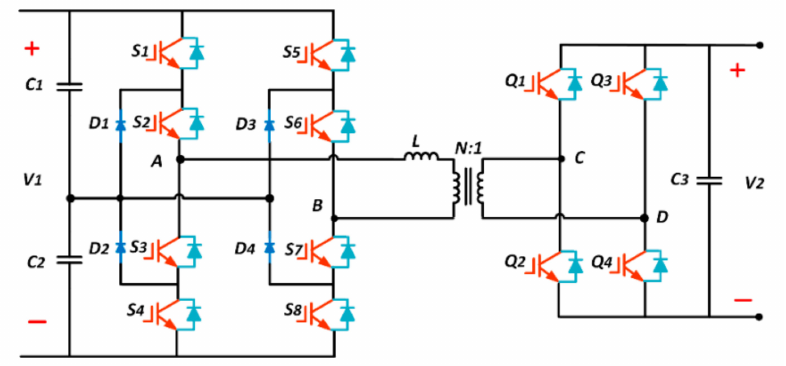
Figure 35. Circuit diagram of five-level NPC DAB converter